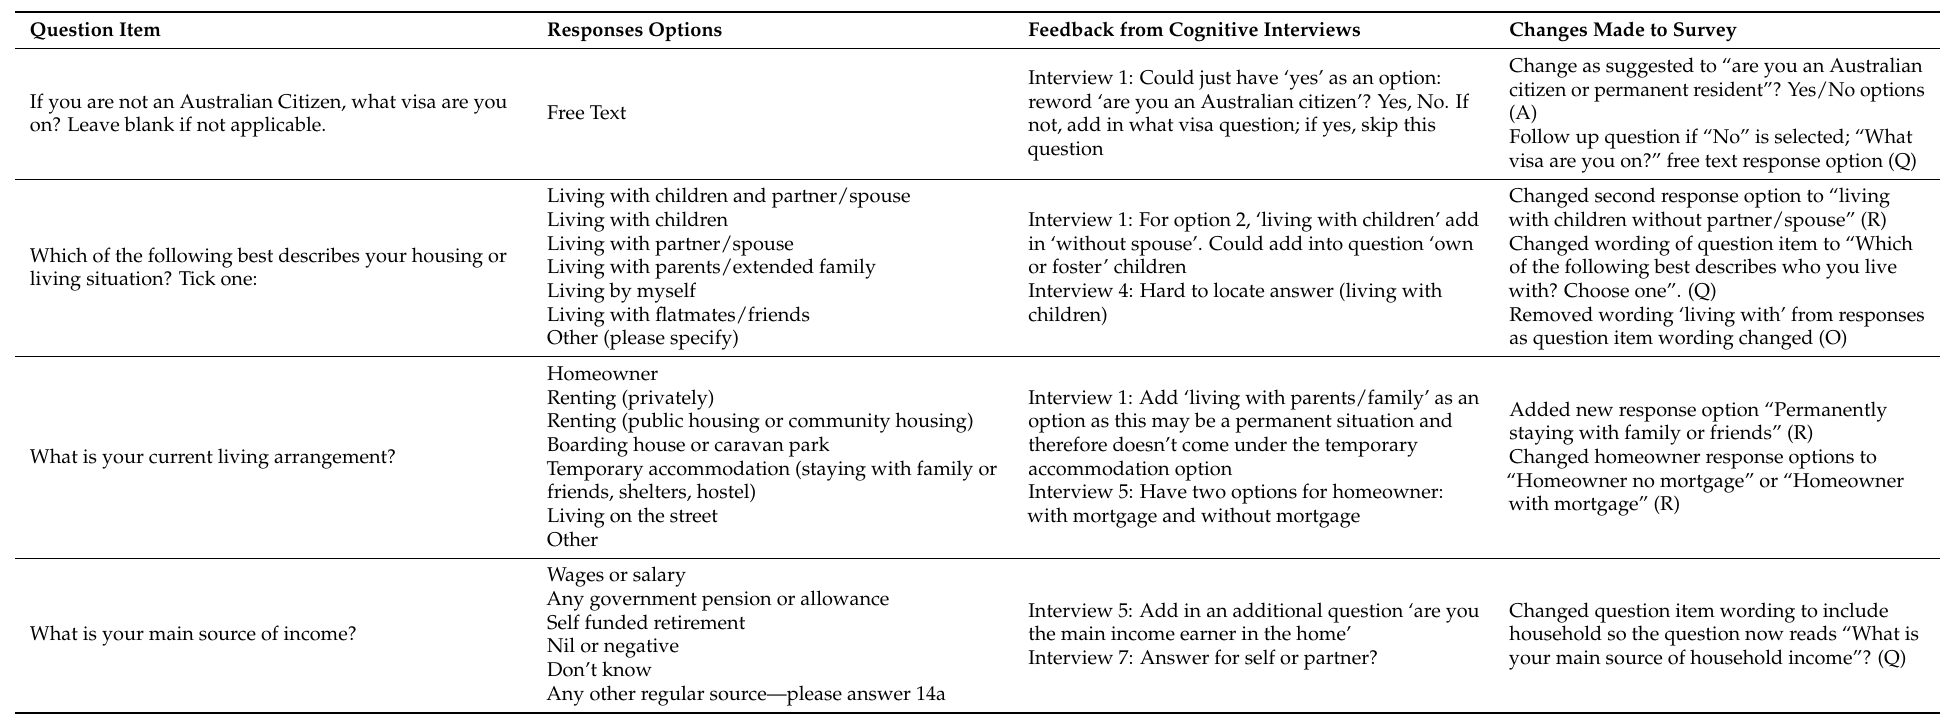
Table A1. Changes made to the survey as a result of cognitive interview